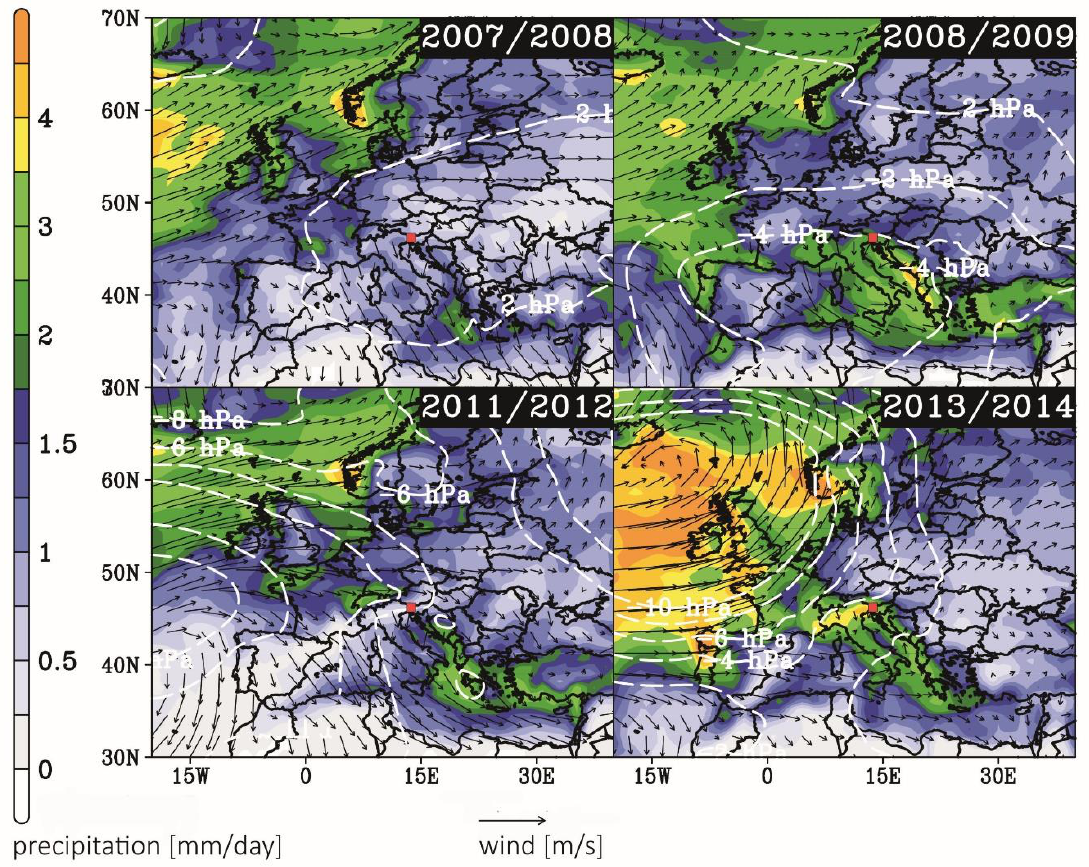
Figure 6. Mean weather patterns observed over Europe during dry (2006–2007, 2011–2012) and extremely snowy winters (2008–2009, 2013–14). Mean seasonal precipitation (mm/day, colours) and near-surface (10 m) mean seasonal winds (m/s) are represented along with the mean sea level pressure anomalies (reference period: January 1981–January 2010, unit: hPa). Well-structured and persistent negative sea level pressure anomalies in the Atlantic influenced the regional circulation in Europe and the Mediterranean causing recursive orographic precipitation in the southern Alps, while positive sea level pressure anomalies manifested in low winter precipitation totals. The red square depicts the region of interest.